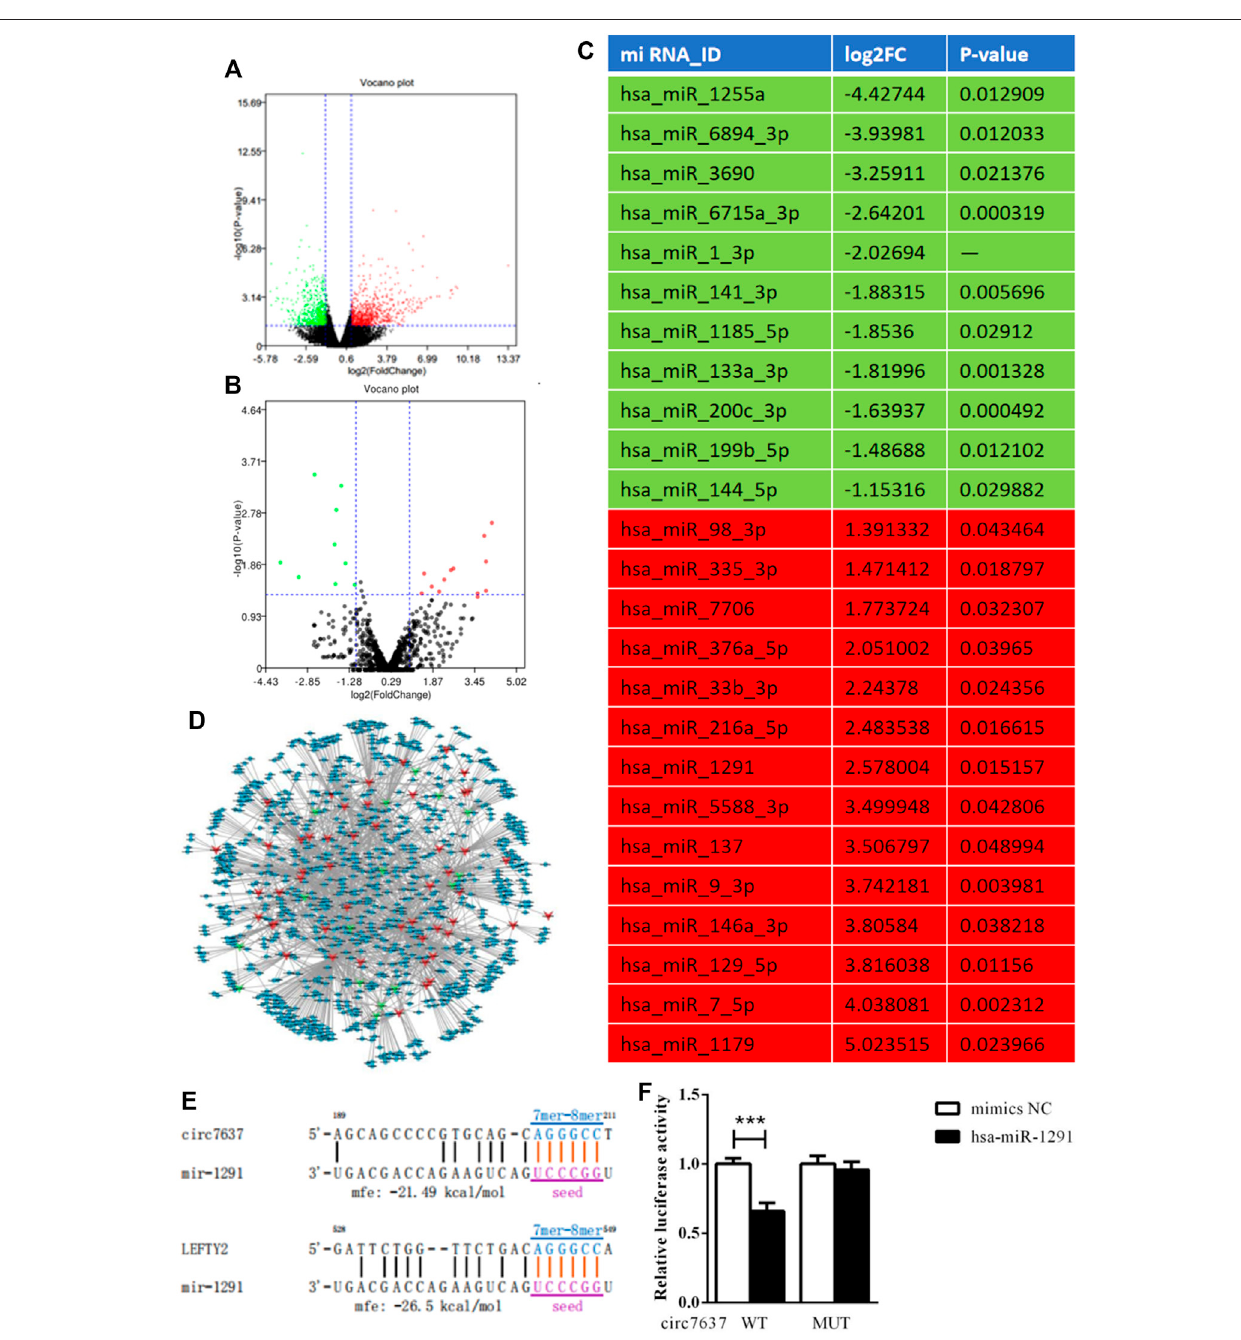
Frontiers in Pharmacology |